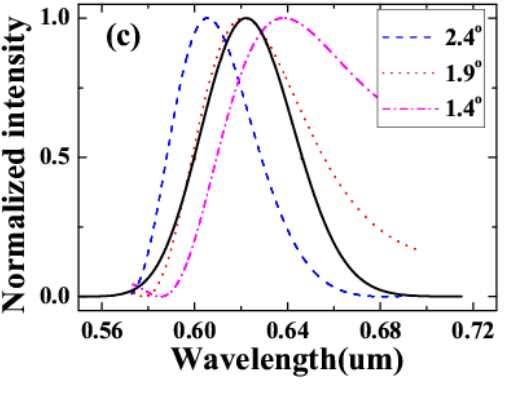
Figure 38. The black solid line is the ideal AS1 signal intensity. The dash-dot line, dotted line, and short-dashed line refer to curves related to phase mismatching L ω ωΔ Ω at 1.4º, 1.9º, and 2.4º, respectively